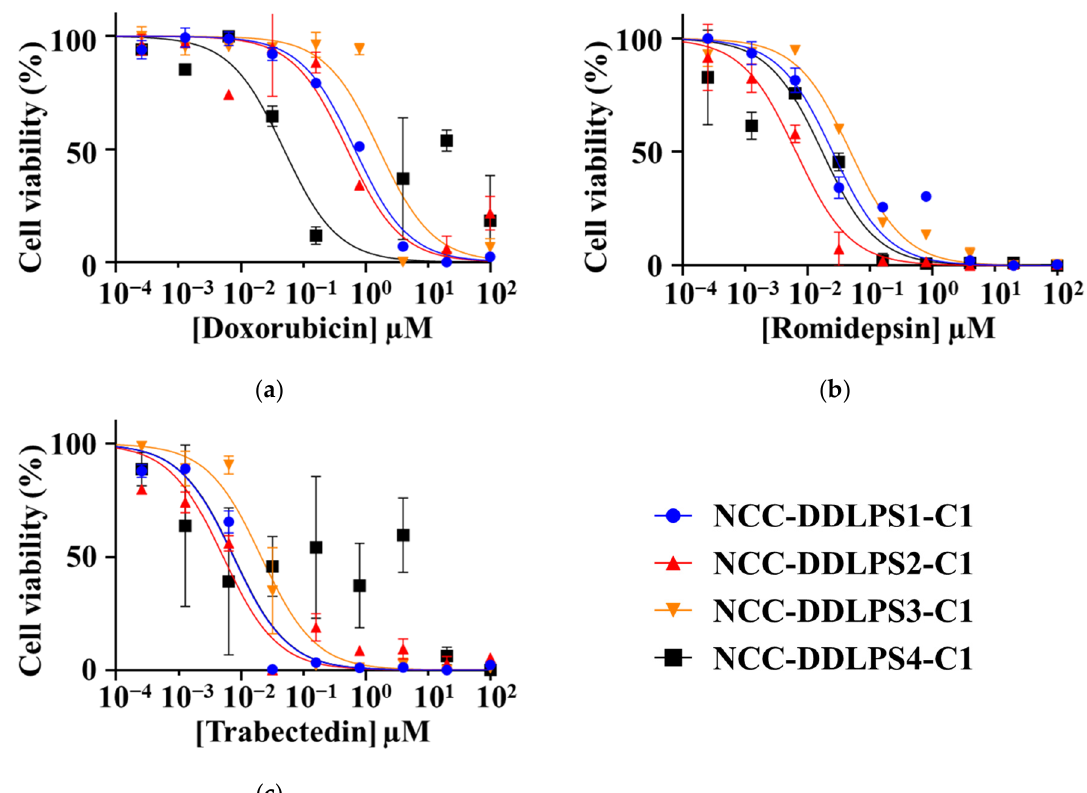
Figure 6. Growth curves for the IC 50 value calculation. Cell viability after the treatment with ( a ) doxorubicin, ( b ) romidepsin, and ( c ) trabectedin at different concentrations is described. The data of NCC-DDLPS1-C1, NCC-DDLPS2-C1, and NCC-DDLPS3-C1 are previously published [31,32]. Table 3. Summary of half-maximal inhibitory concentration (IC 50 ) values ( μ M).